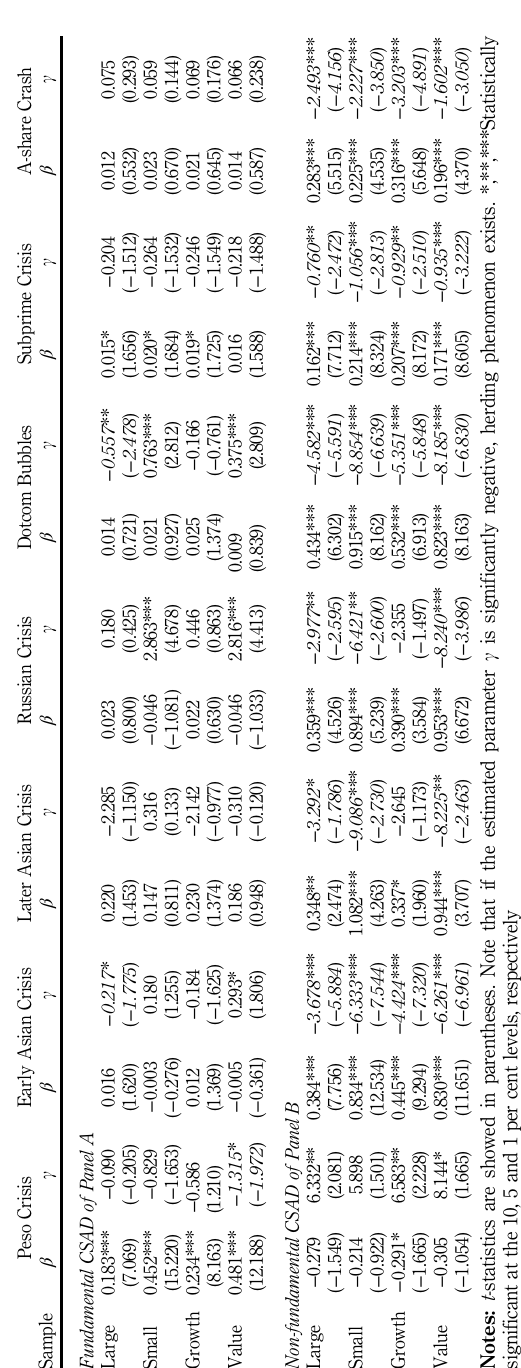
Table VI. B-share market: herding and fundamentals by sub- sample